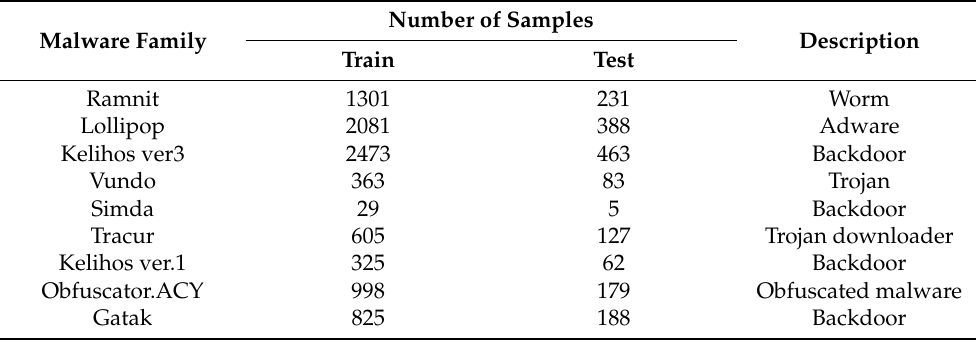
Table 4. Summary of malware data in Dataset